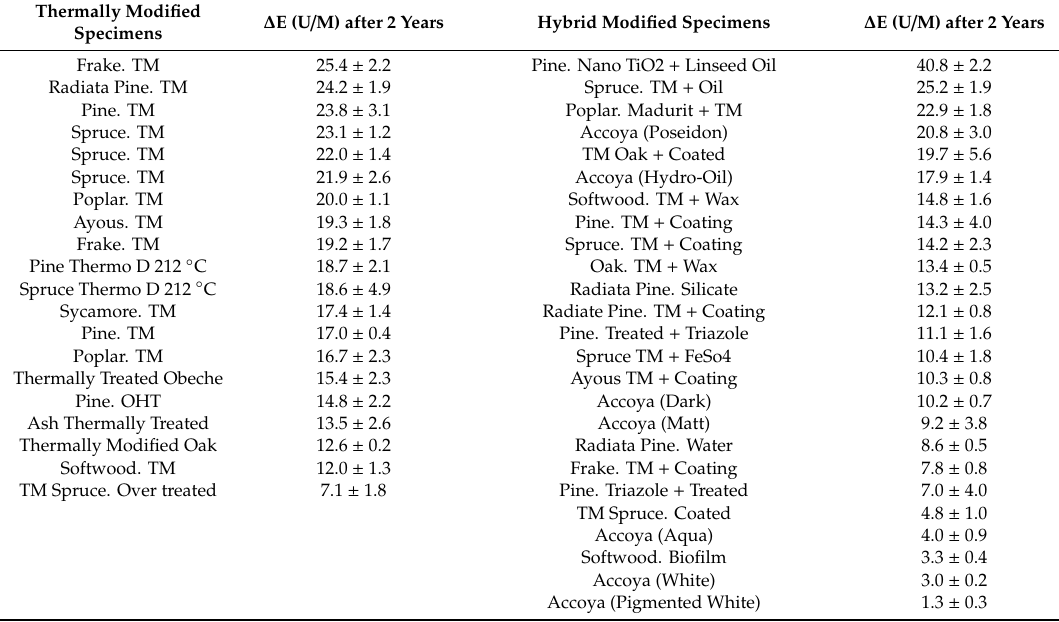
Table 4. Colour change of thermally modified and hybrid treatment